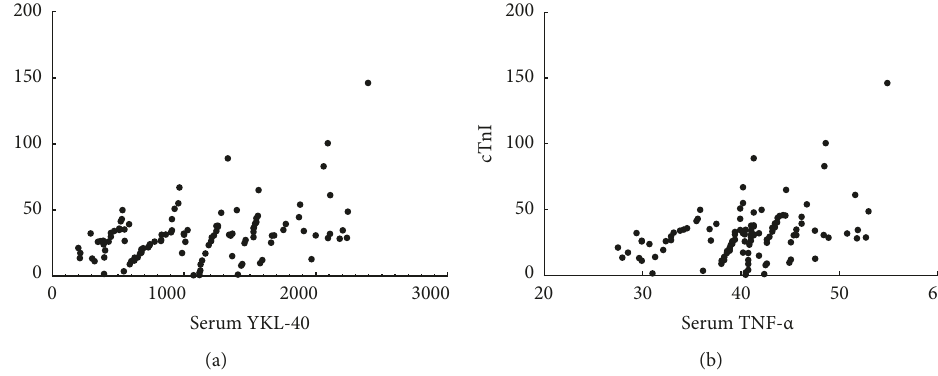
Figure 2: Correlation analysis of serum YKL-40, TNF- α, and